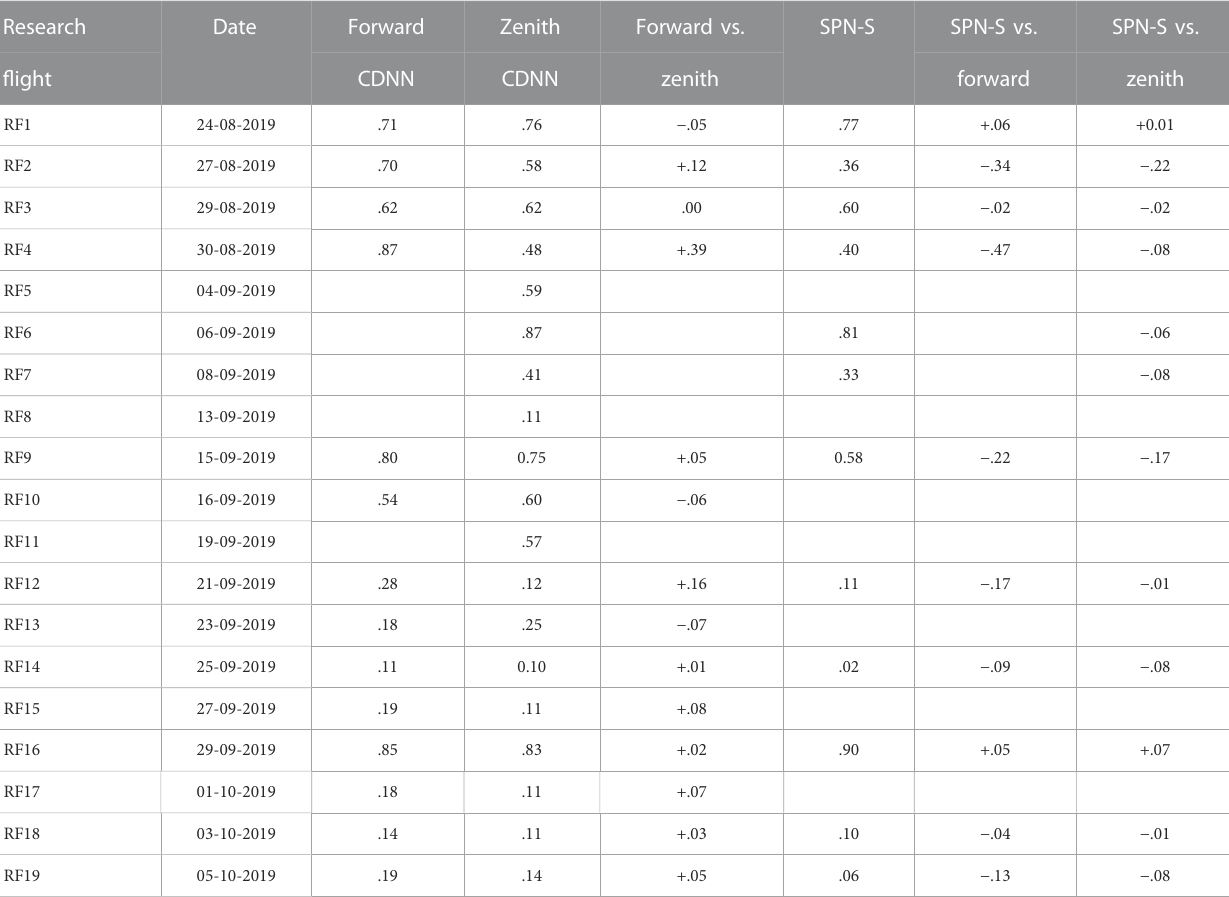
TABLE 3 CAMP 2 Ex 2019 fl ight-averaged cloud fractions. Flight-averaged cloud fractions for each CAMP 2 Ex fl ight. The CDNN fl ight-averaged cloud fraction values re fl ecthowmuchof the fl ightimagery containedobservableabove-aircraftclouds fromeachcamera andSPN-S.TheSPN-Scloudmaskisproduced usingtheCOD at870 nmtocreateaBoolean fi lterwhereCOD > 0.15indicatesthepresenceofcloud;otherwise,itisassumedthereisnocloudpresent.We fi lterforSZA < 45 ° to ensure that the all-sky image crop used for the zenith CDNN includes the Sun. Blank entries indicate missing data. We interpolate the forward and zenith CDNNs and SPN-S onto a common grid, such that we average over the same time interval in each case, that is, only when data from all instruments are present.